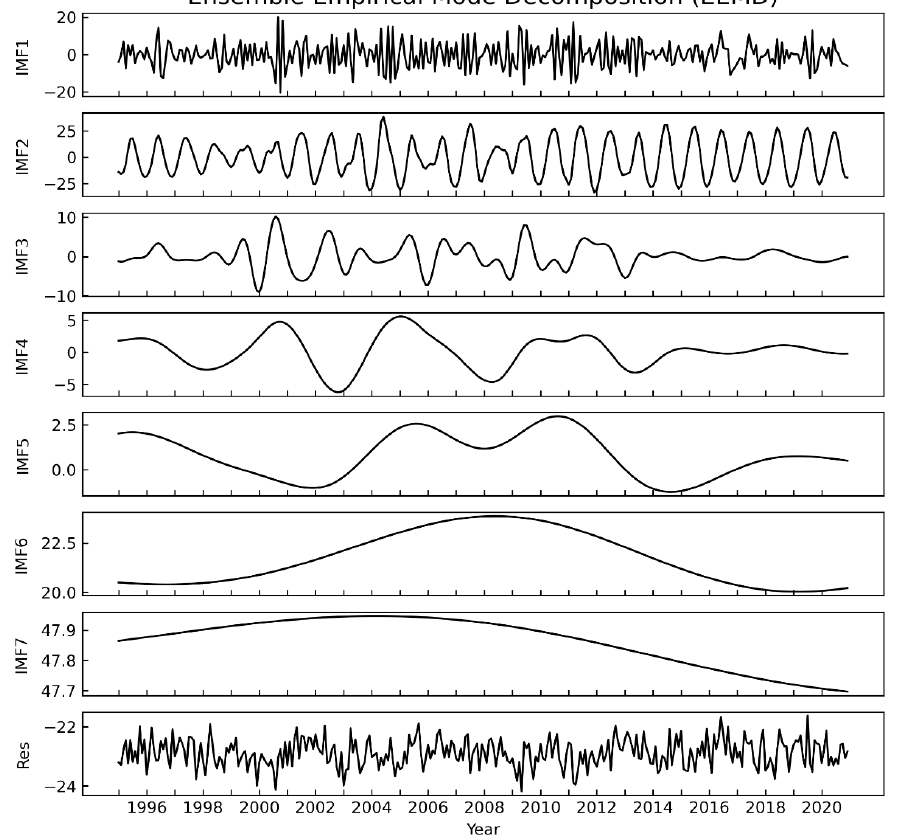
Figure 11. Ensemble empirical mode decomposition of surface ozone in Beijing with its intrinsic mode functions IMF1–IMF7 (from the lowest to the highest-order IMF) and residues. Figure 11 shows the seven IMFs of the EEMD results. IMF1 is the lowest order of EEMD, meaning the highest frequency of ozone time series. We can see that there are different periodic phenomena from IMF2 to IMF5. In order to understand the oscillation periods of IMF2–IMF5, we analyzed the power spectra, as displayed in Figure 12. The oscillation period of IMF2 is one year, which indicates the annual cycle. Tang et al. [56] suggested that the ozone concentration in Beijing is the highest in June and the lowest in December, which is in agreement with our results (Figure 6a). The abundant solar radiation and the damp air condition in summer is favorable for ozone production [57]. The maximum Beijing ozone concentration in early summer is possibly related to the East Asian summer monsoon (EASM) shifting to an earlier date [58]. There is a ~2–3 years peak in the power spectrum of IMF3 (Figure 12b), which is close to the period of the Quasi- biennial Oscillation (QBO). The QBO is the dominant mode of interannual variability in the equatorial stratosphere with a period of ~28 months. IMF4 shows a significant peak of 3~9 years (Figure 12c), which may be related to the El Niño–Southern Oscillation (ENSO). IMF5 has the periodical fluctuation of around 20 years (Figure 12d) and is possibly affected by climate systems with a longer cycle, such as the Pacific Decadal Oscillation (PDO). IMF6 and IMF7 are not periodic but show the long-term tendency of ozone. IMF6 shows an increase in the first stage before 2008 and a decrease afterwards. On much longer time scale, Beijing surface ozone mixing ratio at 14:00 BJT shows a slight decrease as dis- played in IMF7, which is consistent with the long-term linear trend (Figure 6).